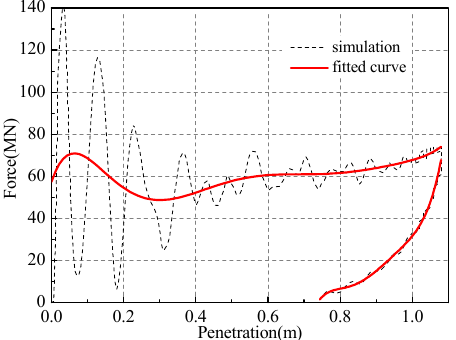
Figure 10. The force–penetration curve.